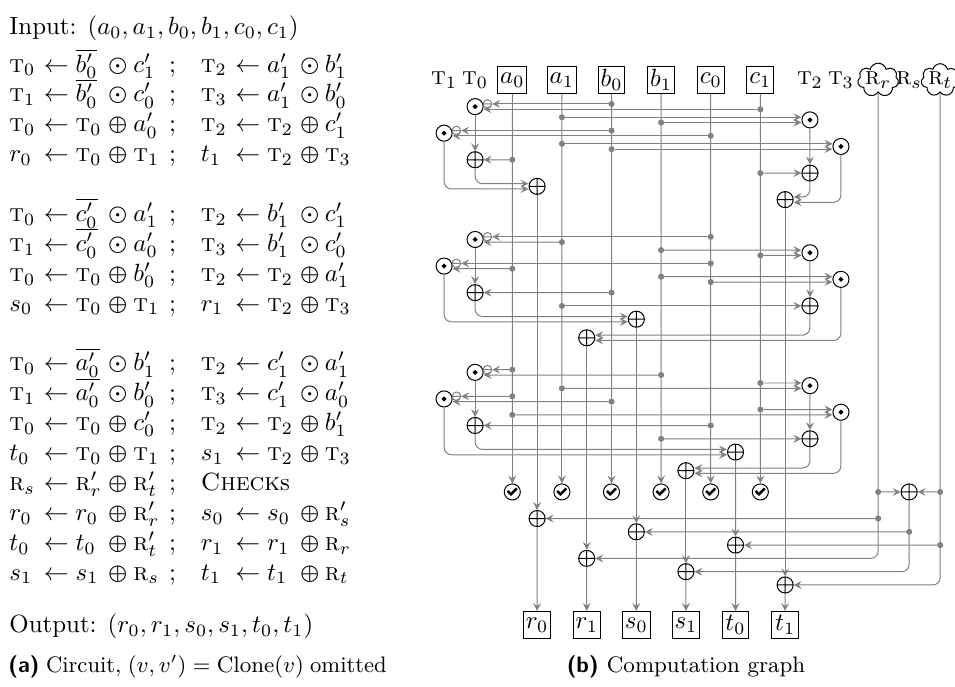
Figure 4: Single-fault SIFA-resistant χ 3 using 2 shares, with local checks. Check s is short